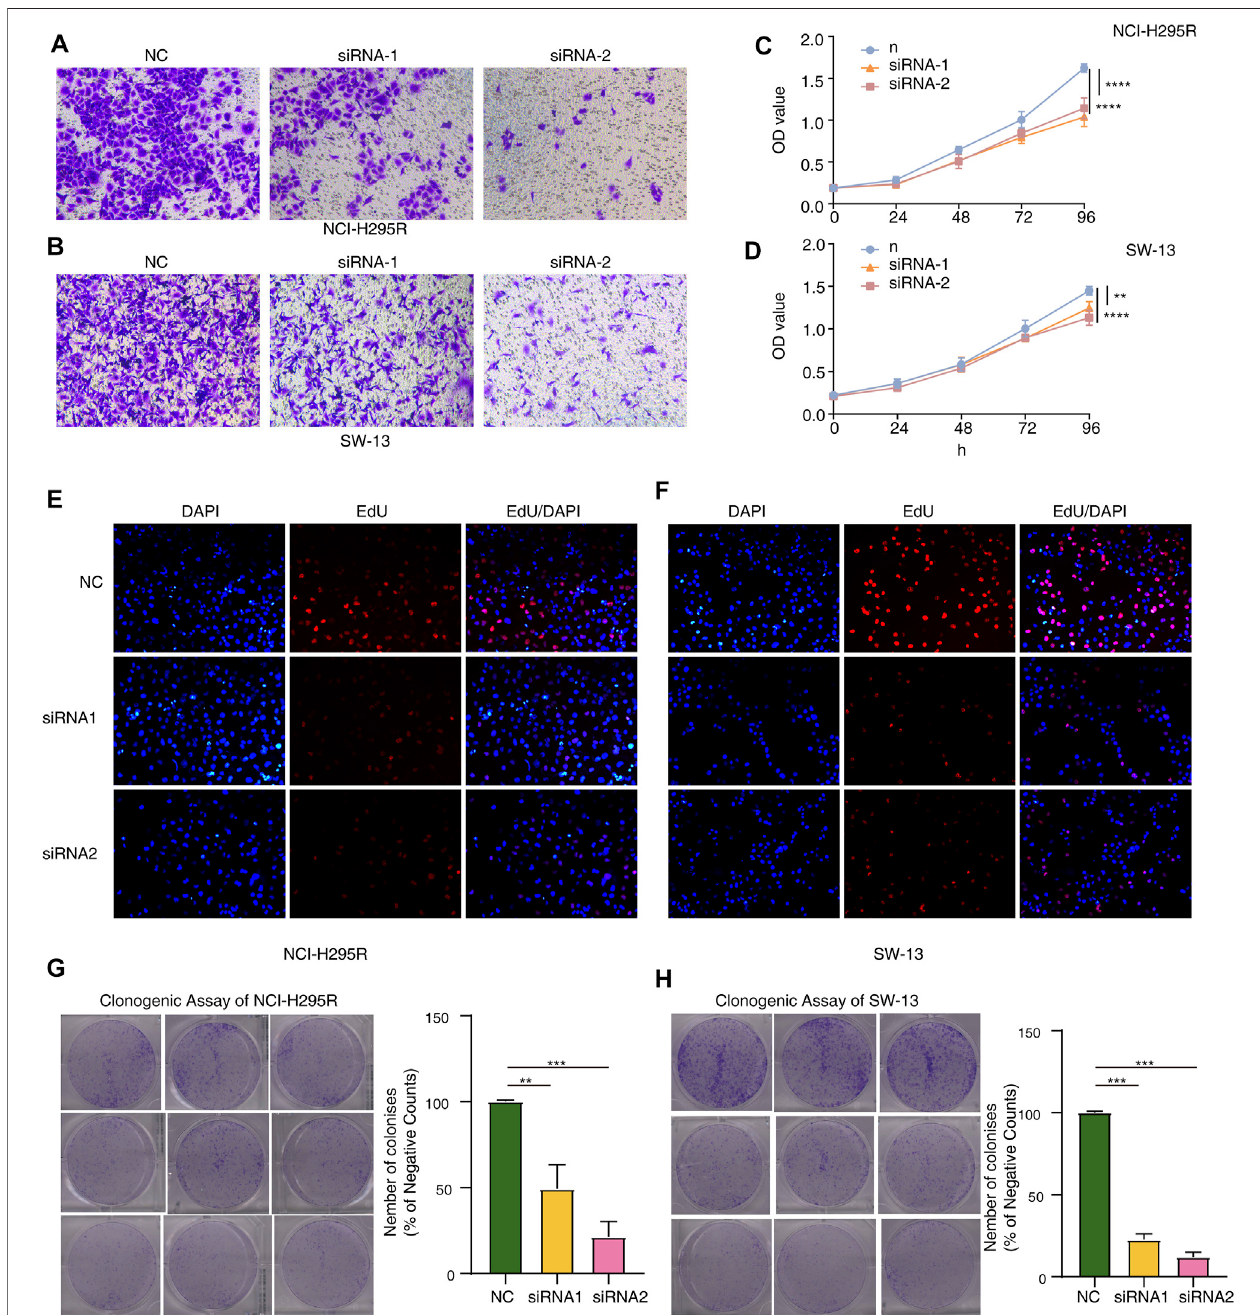
FIGURE7 | Functional validationwithAL359643.3 knock-down. (A,B) Transwell assaywasperformed tomeasure the impact ofAL359643.3 knock-down on the invasiveness of NCI-H295 (A) and SW-13 (B) cells. (C,D) CCK8 assay was utilized to measure the impact of AL359643.3 knock-down on the proliferation of NCI-H295 (A) and SW-13 (B) cells. (E,F) EdU-positive cells are in the si-AL359643.3-treated group relative to their si-NC counterparts in NCI-H295 and SW-13 (F) cultures. (G,H) Colony formation assay was performed of different groups in NCI-H295 (G) and SW-13 (H) cells (** p < 0.01, *** p < 0.001, **** p < 0.0001).